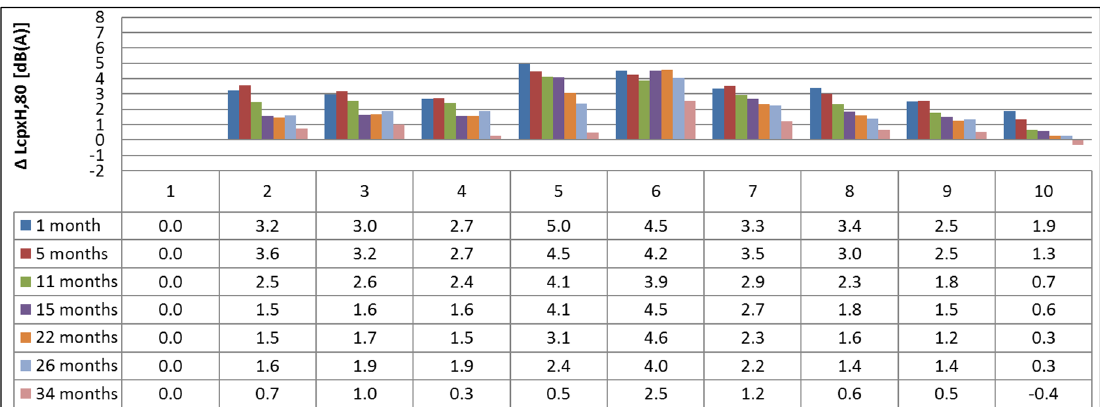
Figure 10. Overview of the noise reduction, based on the CPX results (H1 tire) with temperature correction.